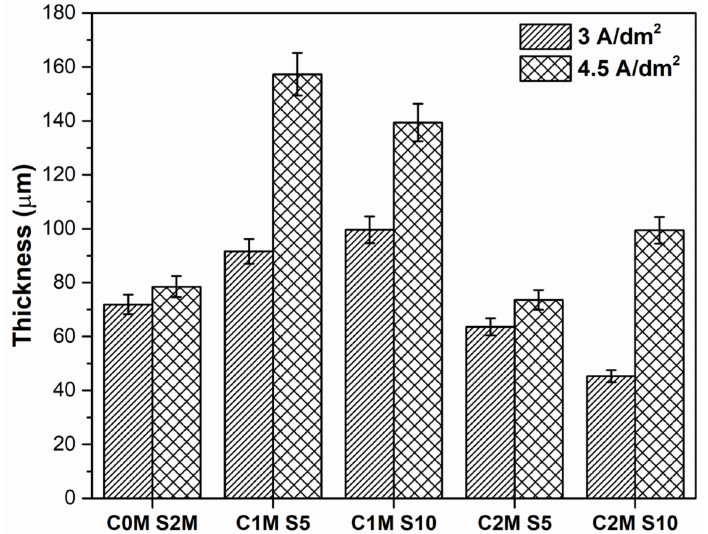
Figure 5. The thickness of the coatings of the samples anodized with current densities of 3 and 4.5 A/dm 2 in different